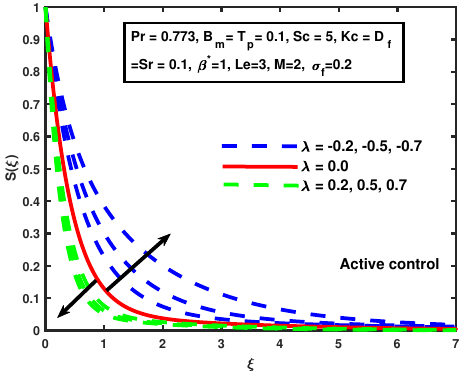
Figure 12. The impact of S ( ξ ) on suction/injection λ (active control